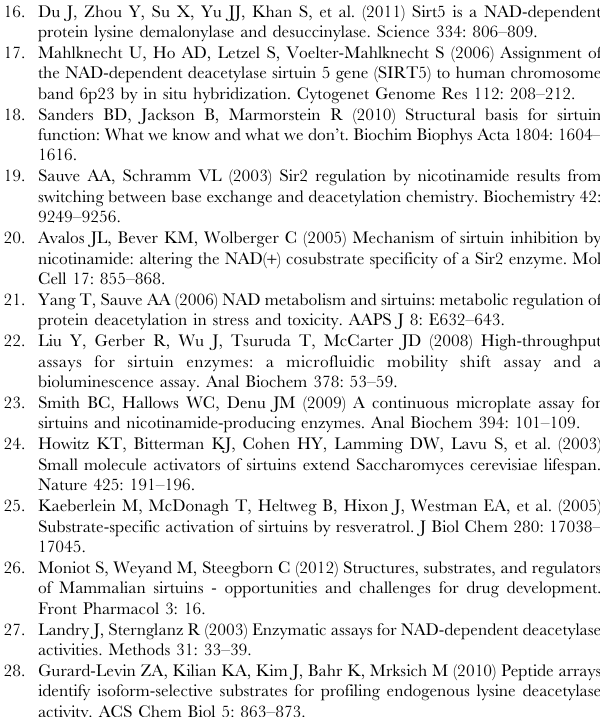
Table S1 Mass spectrometry raw data for Figures